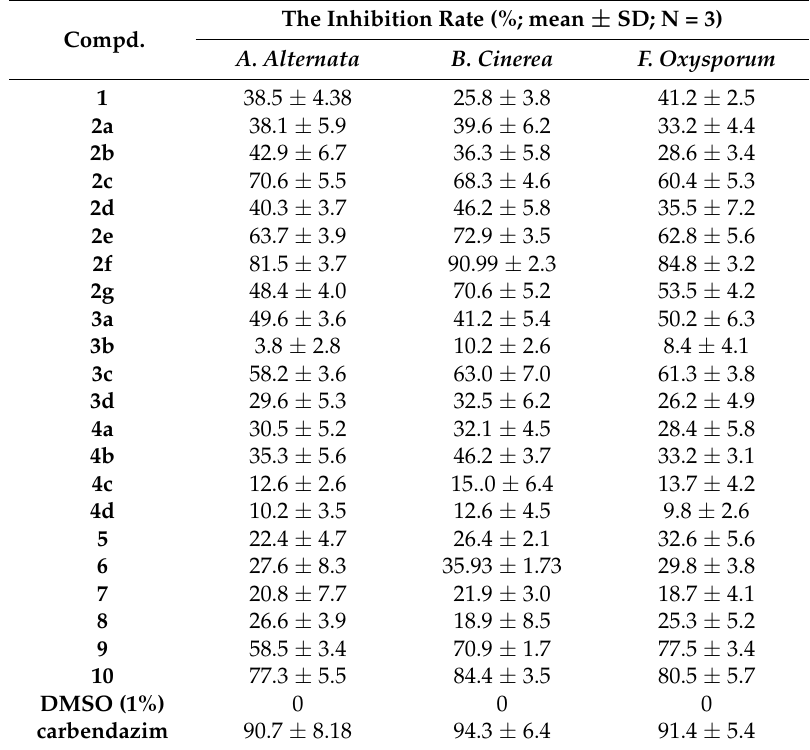
Table 1. In vitro fungicidal activities of the prepared compounds at 100 ug/mL (96 h of incubation). Compd.